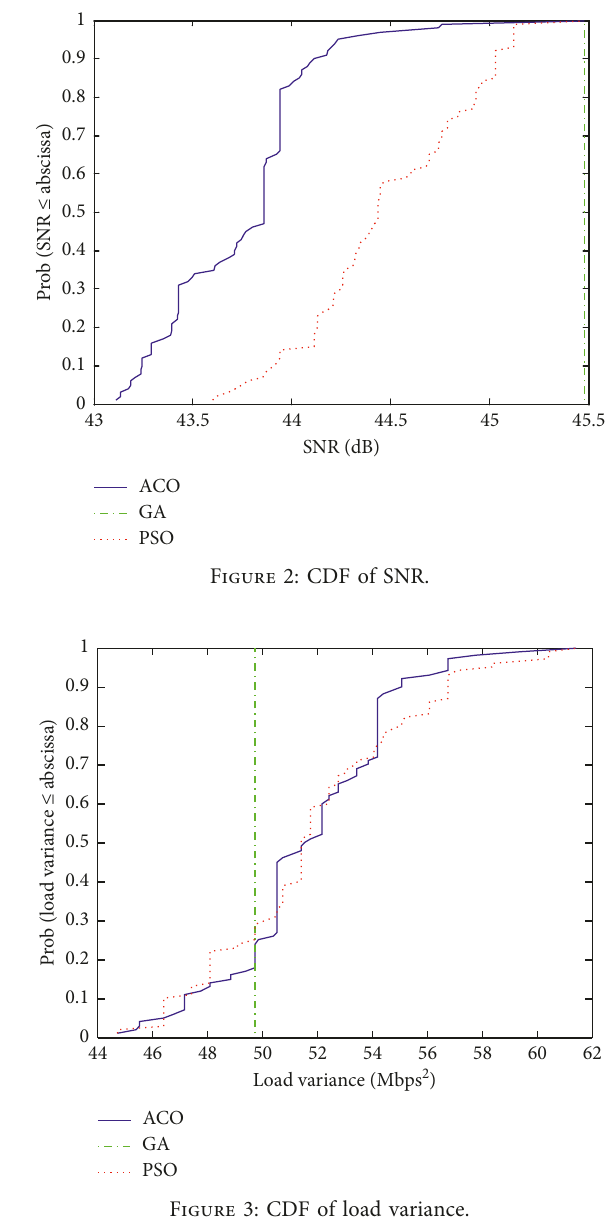
Figure 3: CDF of load variance.